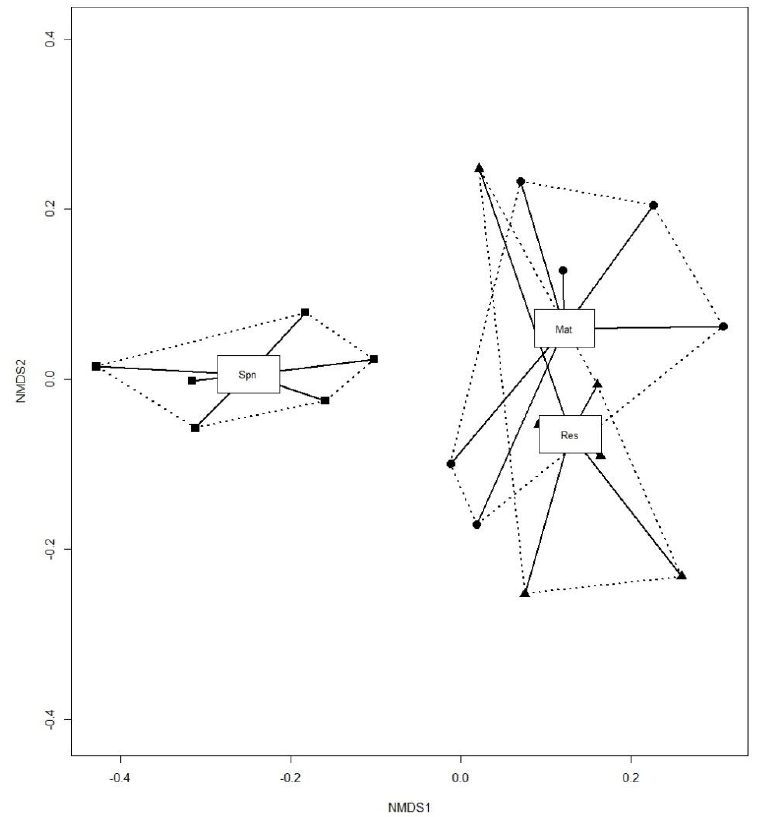
Figure 3. Non-metric multi-dimensional scaling (NMDS) ordination plot of the dissimilarities in the collembolan assemblages in different forest types. ▪ Spn —spontaneously developed stands, ● Mat— mature stands in managed forests, ▲ Res — old-growth stands in Strict Reserve. Stress 0.18.